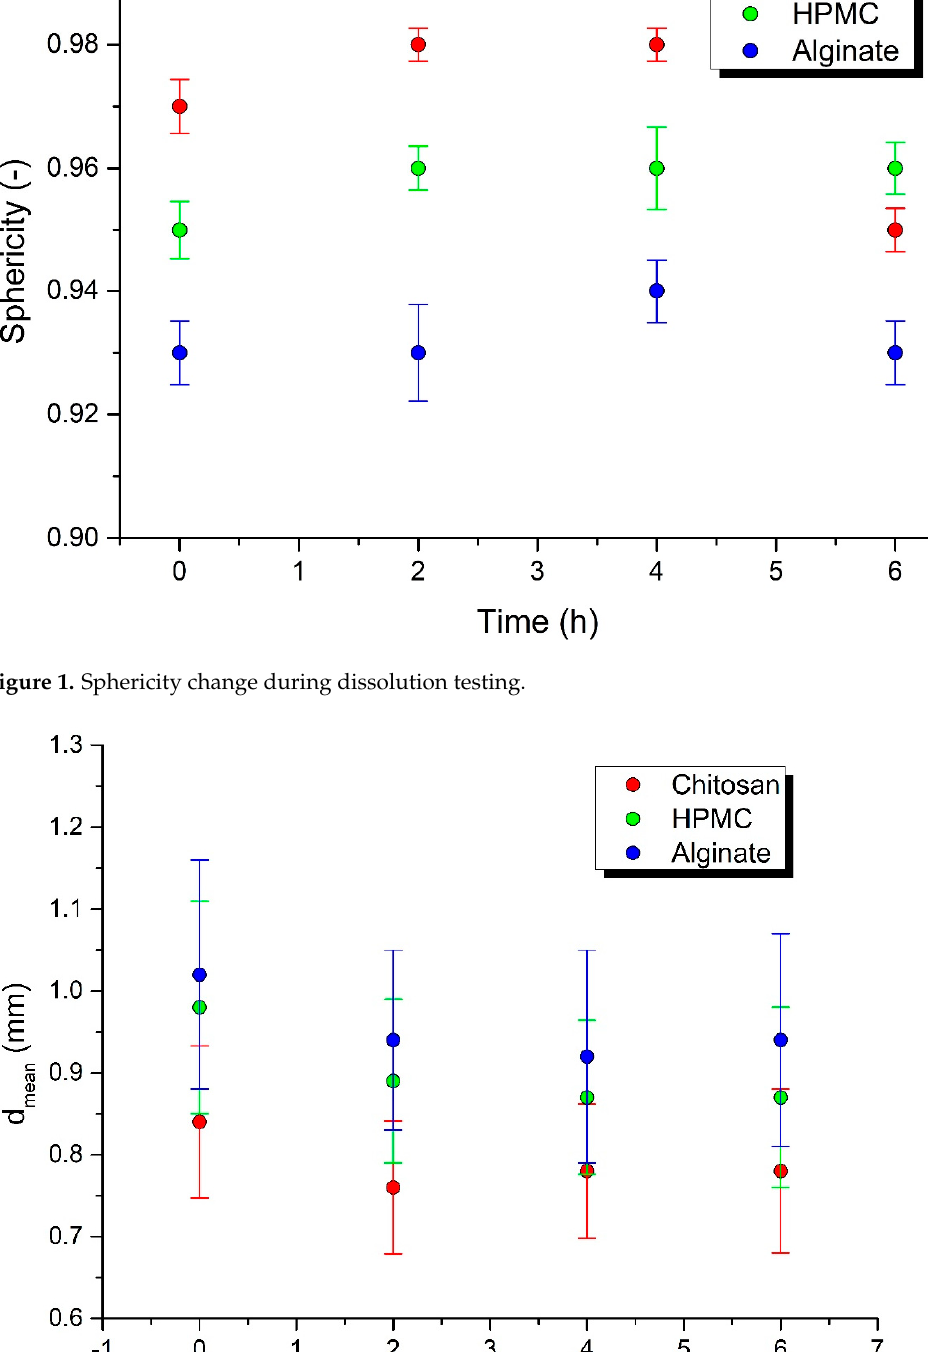
Table 2. Pellet size alteration and sphericity alteration during dissolution testing.